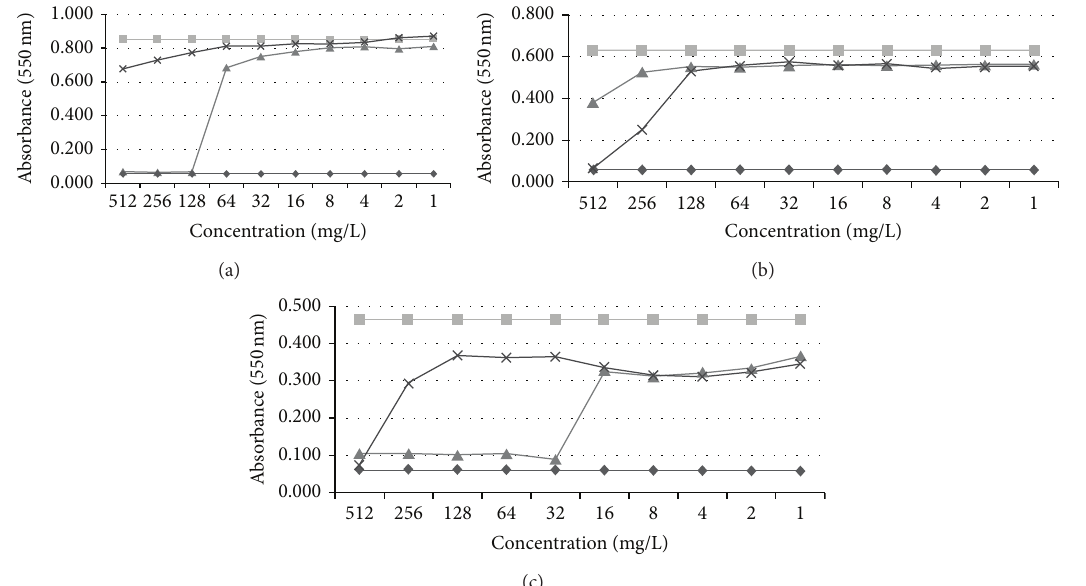
Figure 4: Dose-response curves of synthetic balteatide ( 󳵳 ) and sauvatide ( × ) with the three model test microorganisms: (a) Escherichia coli (NCTC 10418), (b) Staphylococcus aureus (NCTC 10788), and (c) Candida albicans (NCPF 1467).